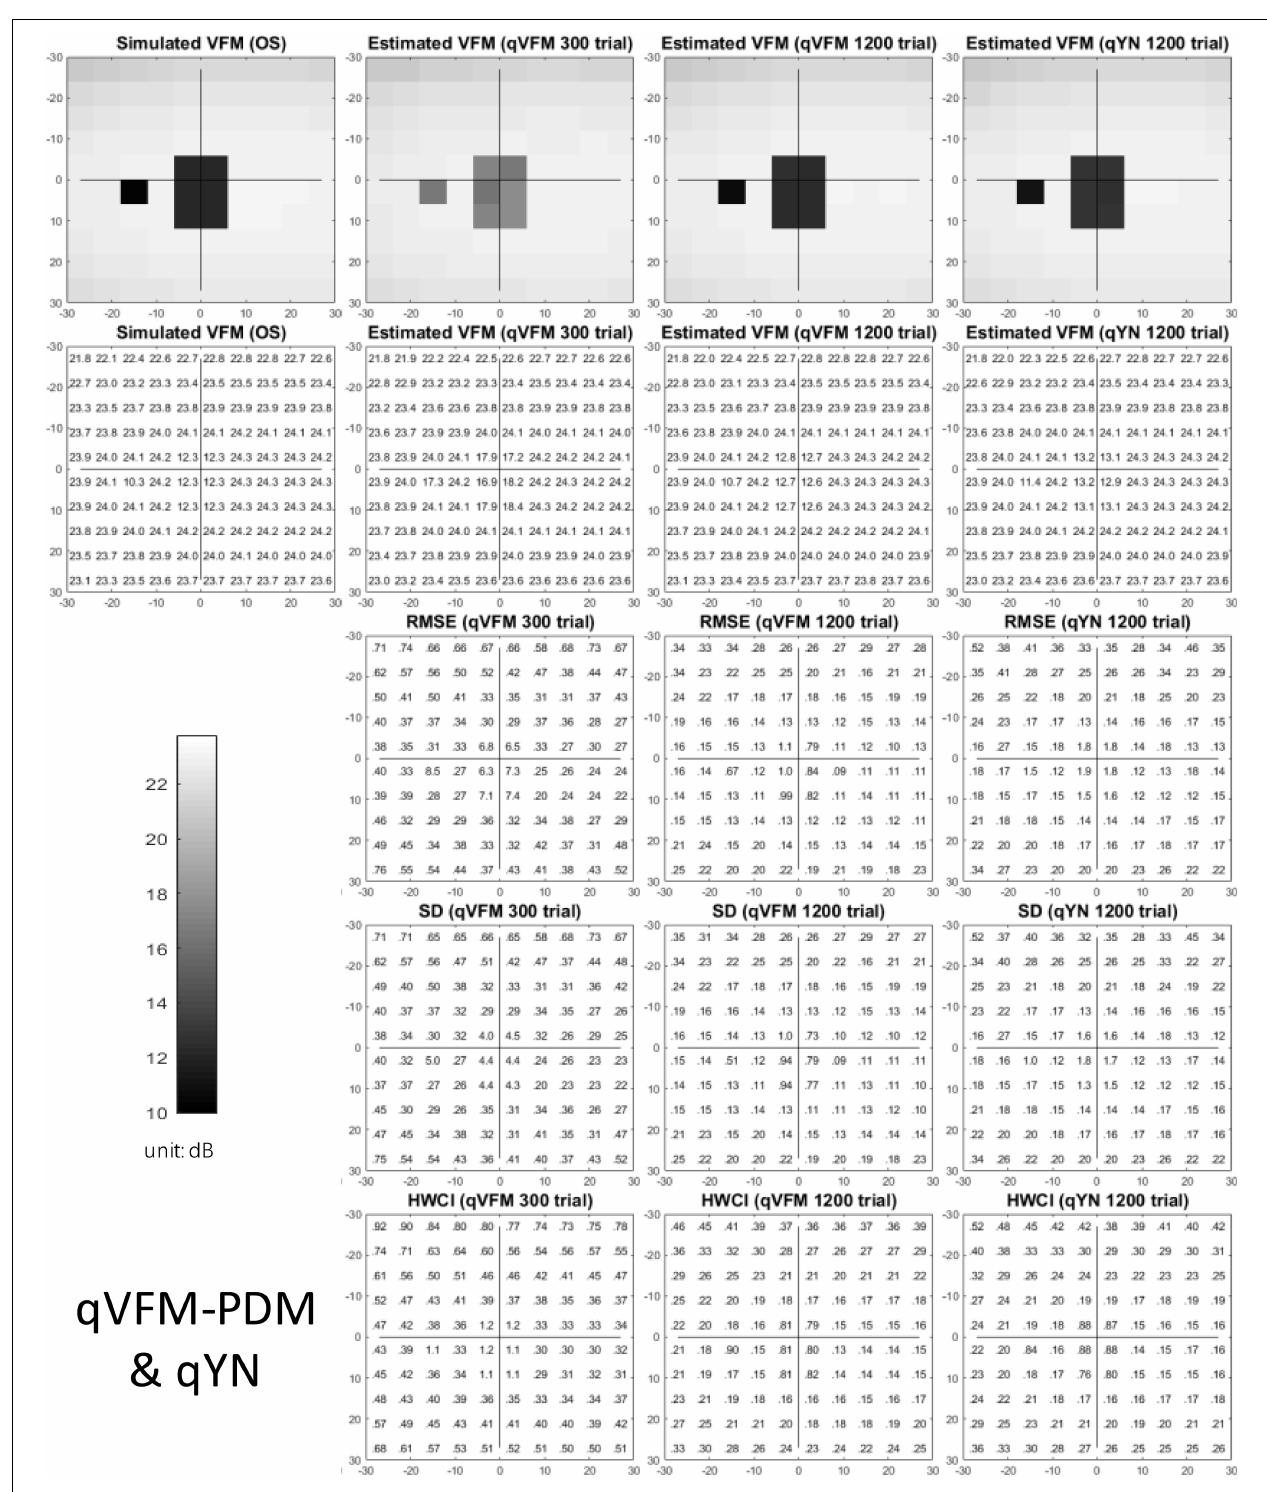
FIGURE 8 | Simulation results I of the AMD observer across 200 runs. The true VFM of the simulated observer (monocular) is presented in the first column of the first row with achromatic colormaps and second row with numerical values. The estimated VFMs obtained with the qVFM-PDM method after 300 trials and 1,200 trials, qYN method after 1,200 trials are presented in the first and second rows, respectively. The corresponding RMSE, SD, and 68.2% HWCI of the estimates are shown in the third, fourth, and fifth rows.